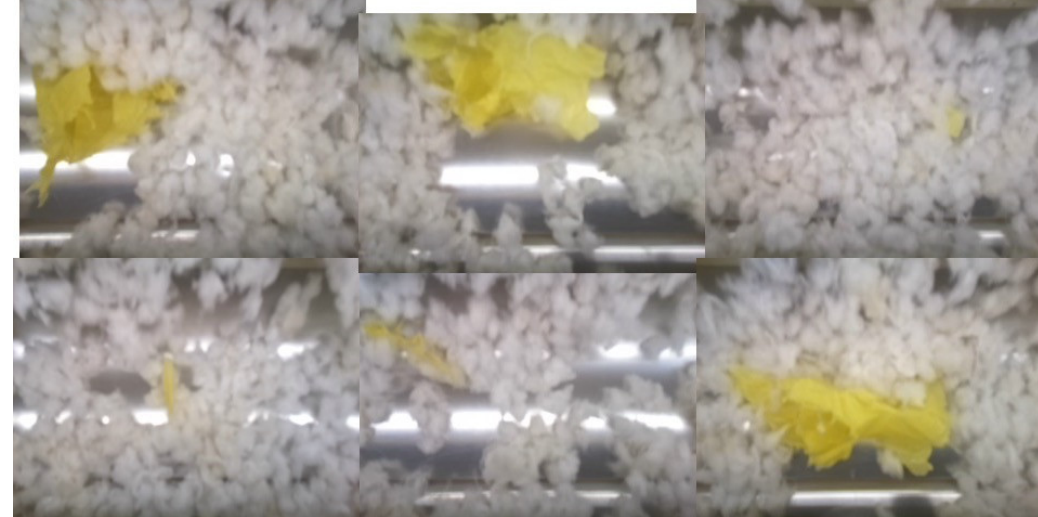
Figure 8. Module wrap plastic contaminants that were detected during a commercial field trial of the plastic inspection– detection and ejection system, “PIDES”.